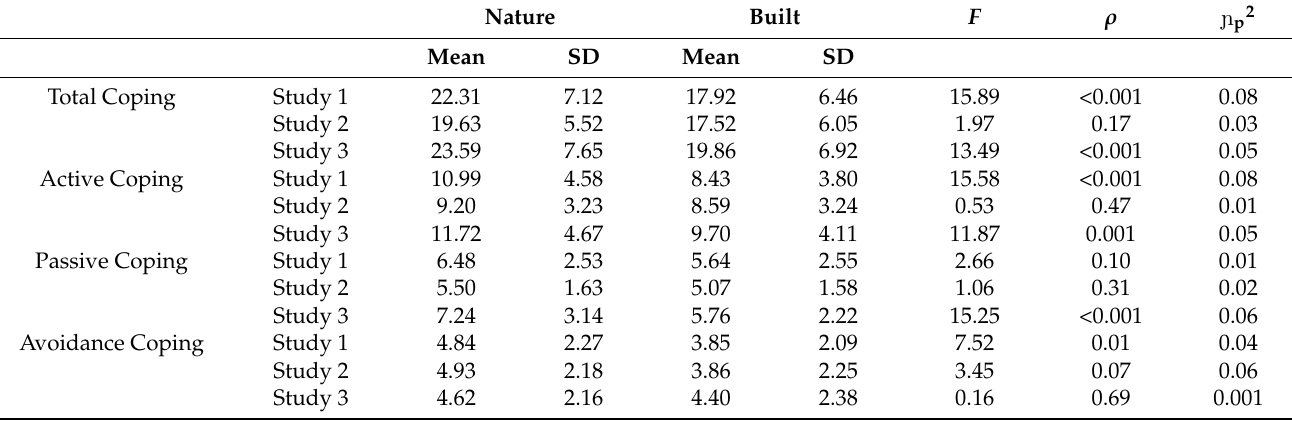
Table A2. Descriptive and Test Statistics for the Outcome Measures regarding Cognitive